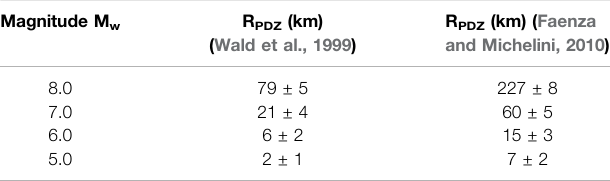
TABLE 3 | Radius of potential damage zone (PDZ) for different magnitudes (Carranza, 2016). Magnitude M